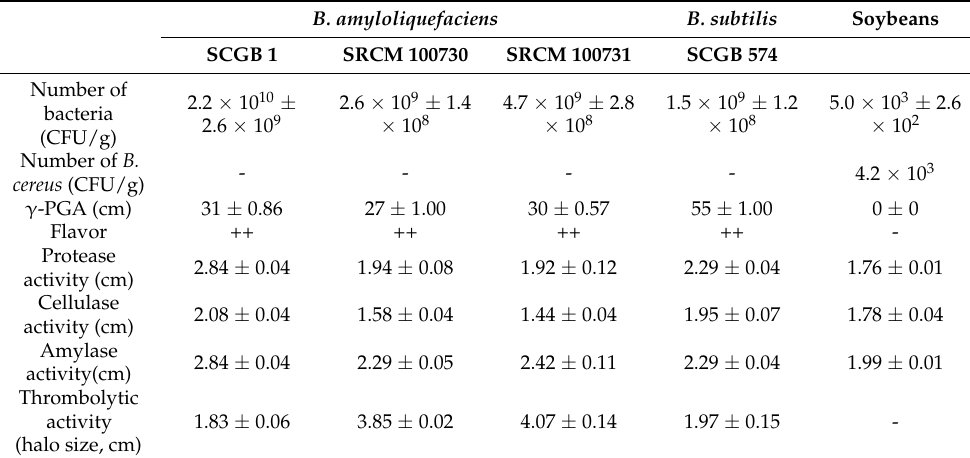
Table 1. The characteristics of chungkookjang fermented with different Bacillus species. B. amyloliquefaciens B.